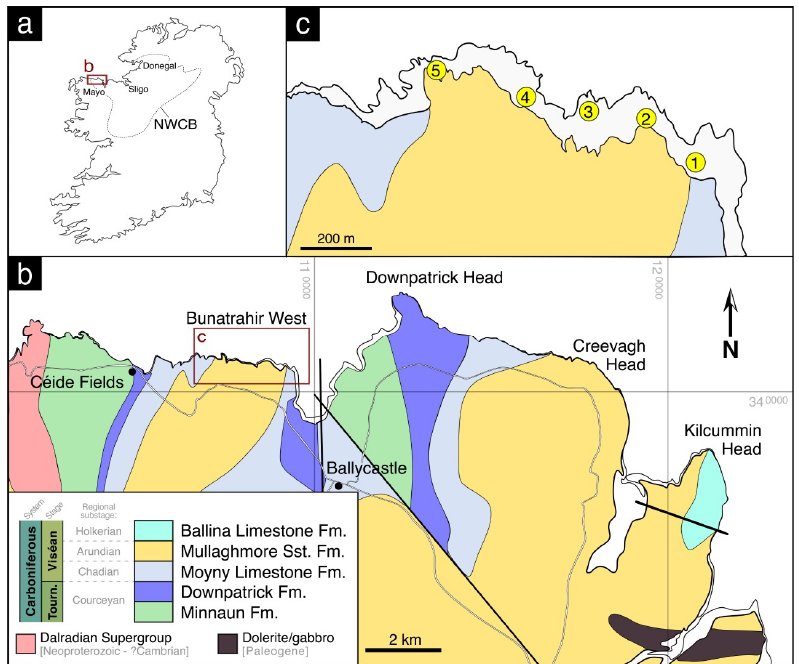
Figure 1. Geographic location and stratigraphic context of the study area. ( a ) Location of the Northwest Carboniferous Basin (NWCB) in Ireland. Inset box shows the location of geological map in b. ( b ) Geological map of North Mayo, after Graham [49]. Inset box shows location of more detailed map of study area in c. ( c ) Mullaghmore Sandstone Formation at Bunatrahir West with sample locations (yellow numbered circles). The lithostratigraphical key is applicable to the maps in b and c; it also shows the chronostratigraphic position of the Carboniferous succession in north Mayo. Placement of regional substage boundaries is quite tentative (they are dashed as a result). Tourn. = Tournaisian Stage. Dalradian Supergroup metasedimentary rocks form the geological basement in the study